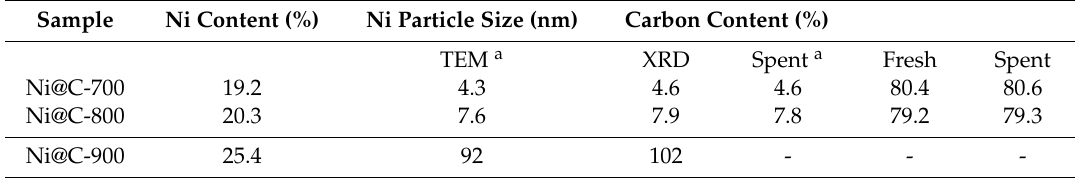
Table 1. Composition and textural properties of prepared Ni@C nanocatalysts.